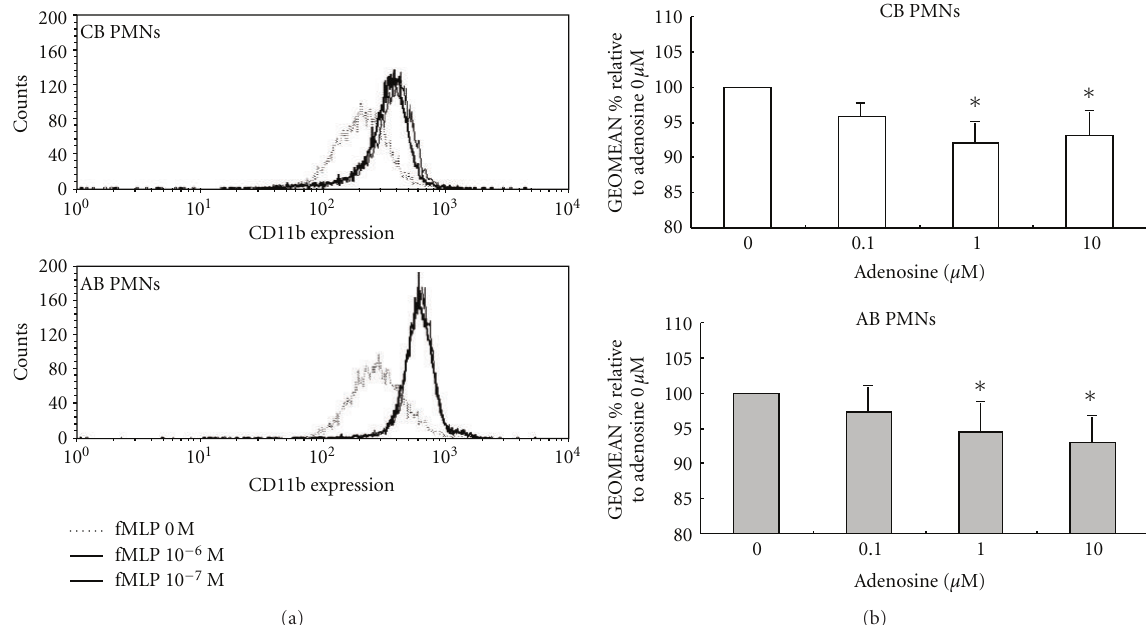
Figure 1: The modulating e ff ects of adenosine on adhesion molecule expressions of neonatal and adult PMNs. (a) Cord blood PMNs always had a lower CD11b expression than adult PMNs upon fMLP stimulation. The results presented are representative of 6 duplicate experiments. (b) Plots illustrate CD11b expression levels (expressed as GEOMEAN % relative to adenosine 0 μ M in the ordinate) of adult and cord blood PMNs. Both in adult and cord blood PMNs, the signal intensities of CD11b were about nine percent decreased with an adenosine concentration of 1 μ M (compared with adenosine 0 μ M). Data are expressed as mean ± SD. ∗ P < 0 . 05 adenosine 0 μ M